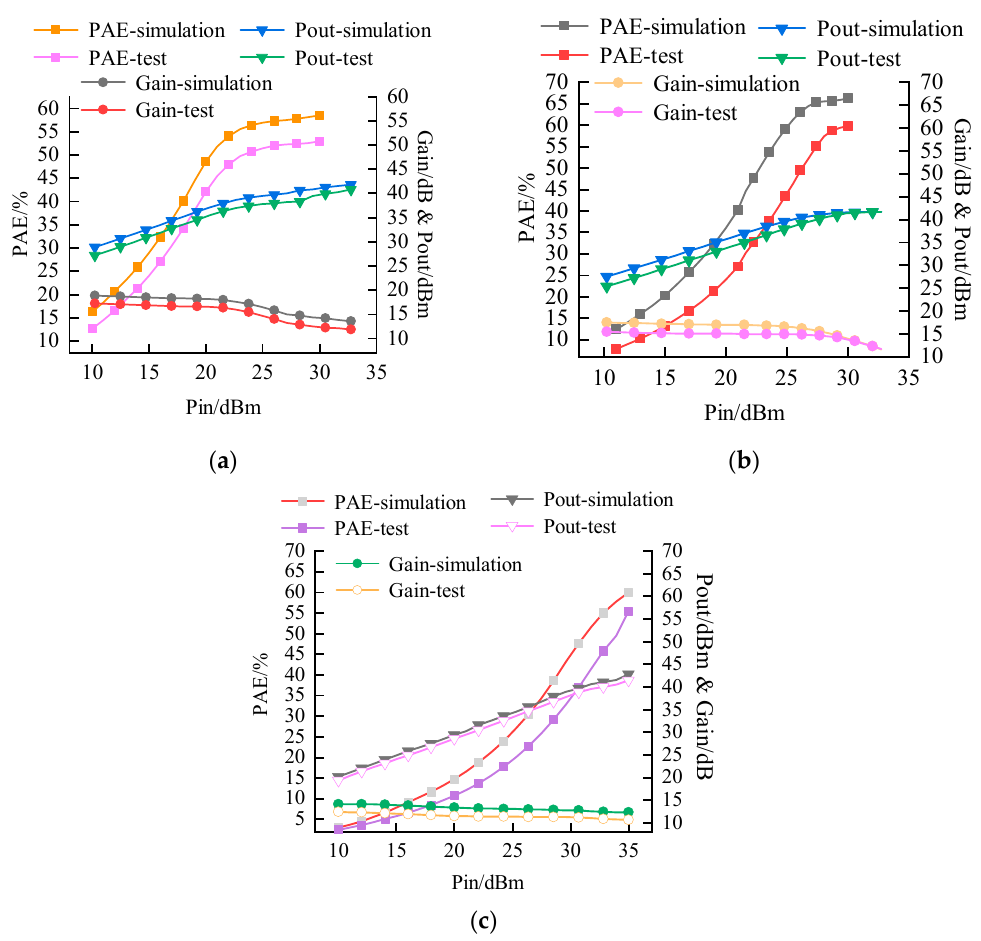
Figure 8. Simulation results and test results of power-additional effect, output power, and gain. ( a ) at 2.2 GHz simulation and test results. ( b ) at 2.6 GHz simulation and test results. ( c ) at 3.5 GHz simulation and test results.